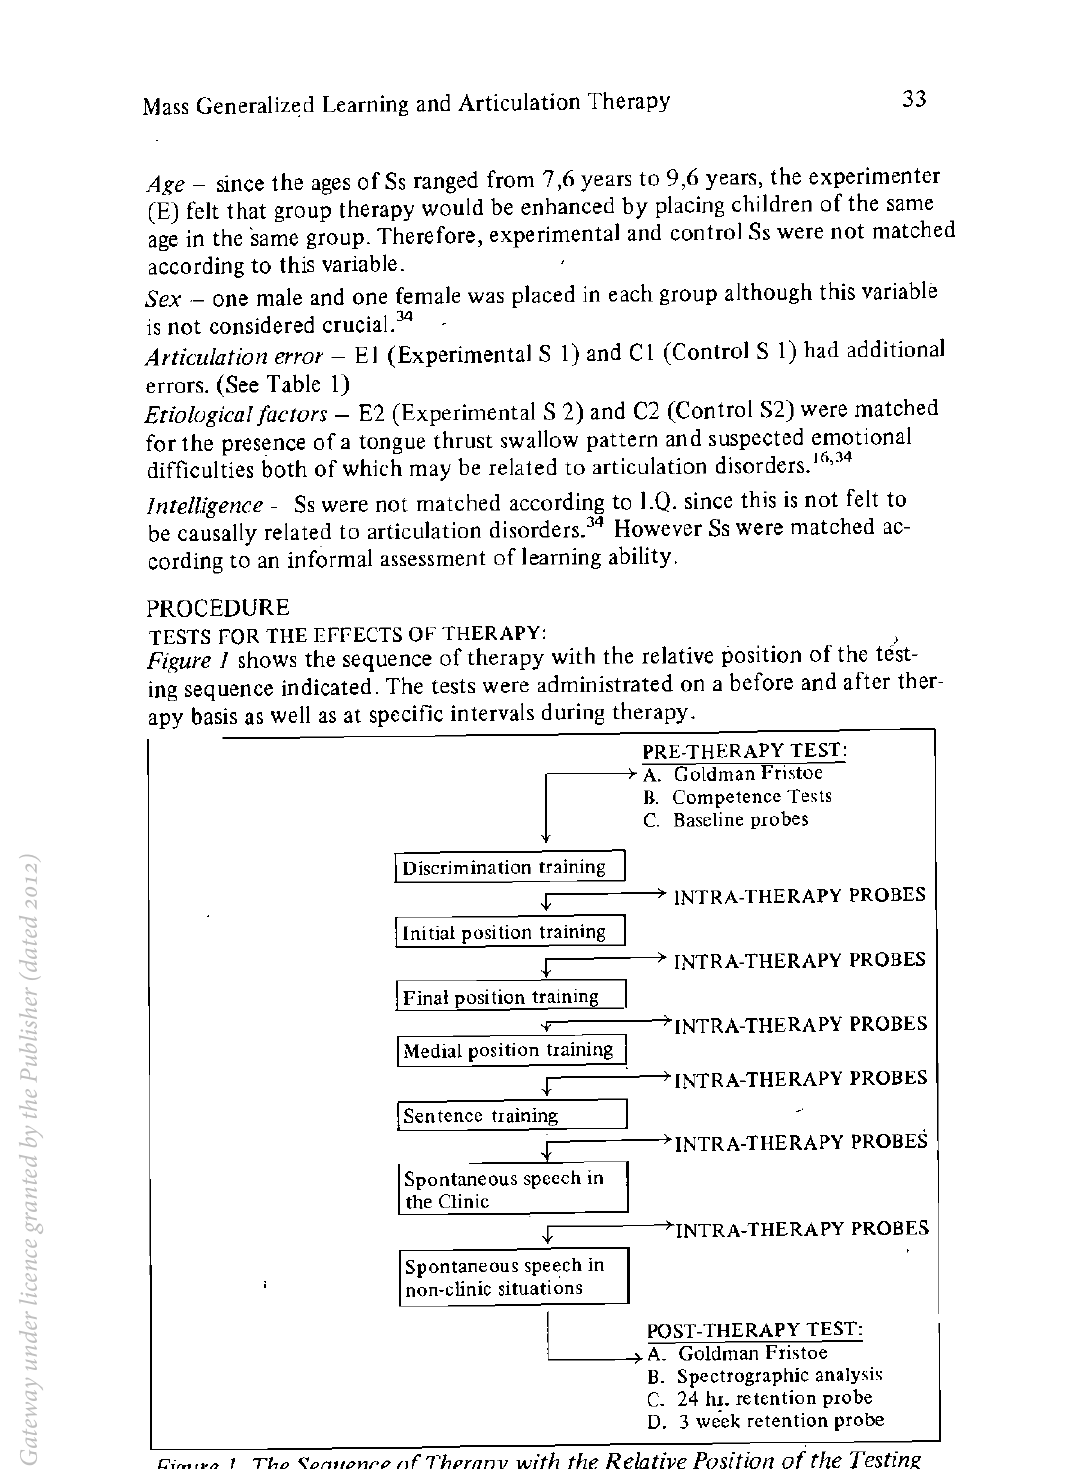
Figure I. The Sequence of Therapy with the Relative Position of the Testing Sequence